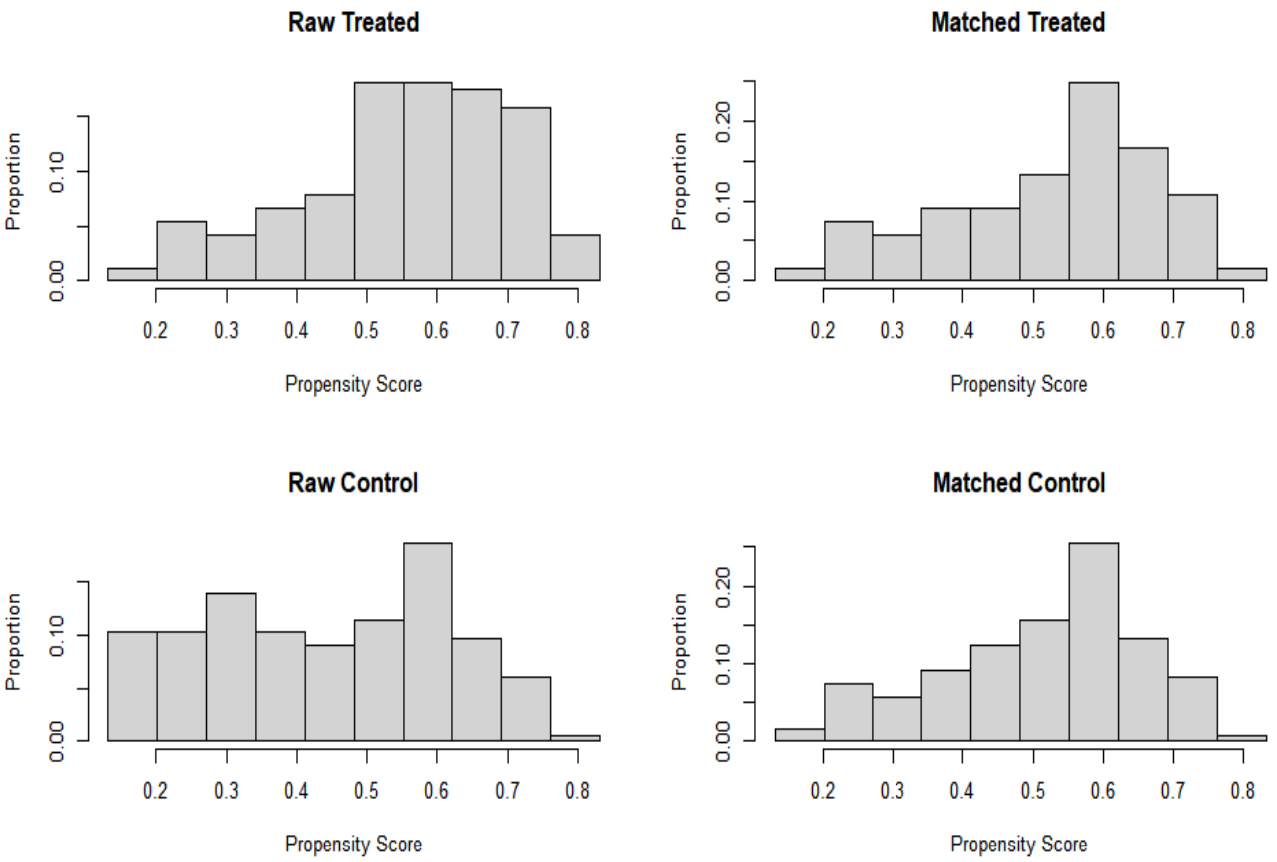
Figure 1. Data balance after propensity score matching.